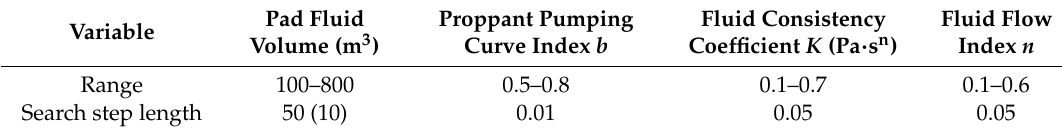
Table 2. Ranges of parameters used in